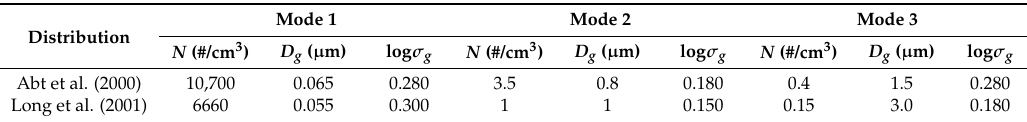
Table 2. Total number concentrations, geometric mean diameters, and geometric standard deviations for the trimodal residential indoor aerosol distributions fit to data reported in Abt et al. (2000) [50] and Long et al. (2001)